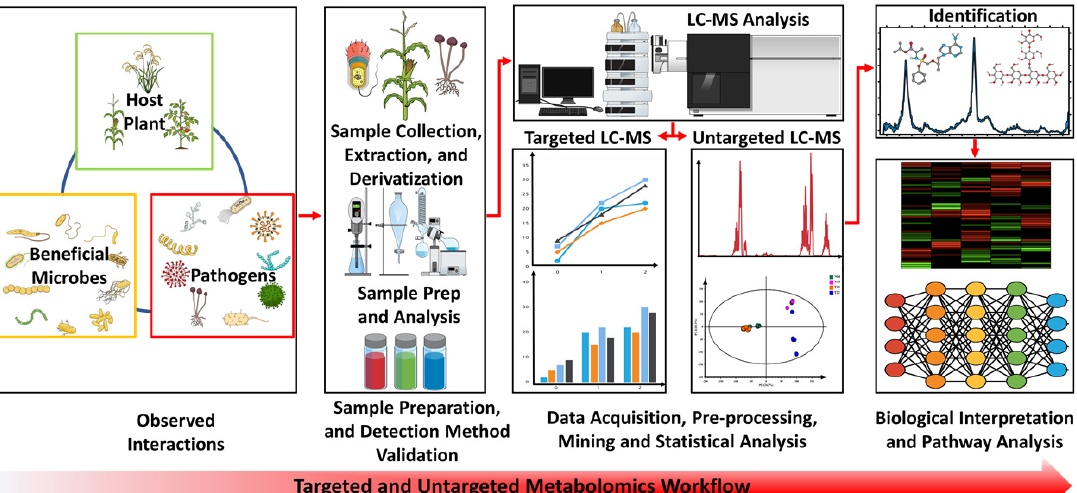
Figure 2. General metabolomics workflow for the analysis of plant–microbe interactions. Metabolomics studies consist of multi-step study designs which can either be targeted or untar- geted. The general metabolomics workflow consists of sample preparation, data acquisition, mining and interpretation of metabolomics data. The workflow depicted above includes the general ob- servations from the sample source in the form of tripartite interactions. Tripartite interactions (plant–phytopathogen–PGPR) result in a metabolite flux between the participating organisms, where phytopathogen metabolites assert a negative impact on both the plant and PGPR. However, such degenerative effects are countered by the beneficial defence and growth metabolites produced and secreted by the PGPR. Plants also produce and secrete metabolites as root exudates used to recruit and cater to a favourable environment for the beneficial PGPR. Such metabolomics studies have been applied to analyse the metabolic perturbations occurring in plants and PGPR when inoculated to induce heightened defence responses or promote plant